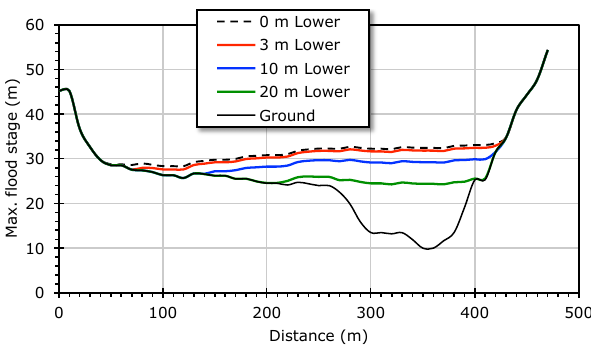
Figure 11. GLOF hydrographs at Phakding under current conditions for 0 m, 3 m, 10 m and 20 m lake lowering scenarios.